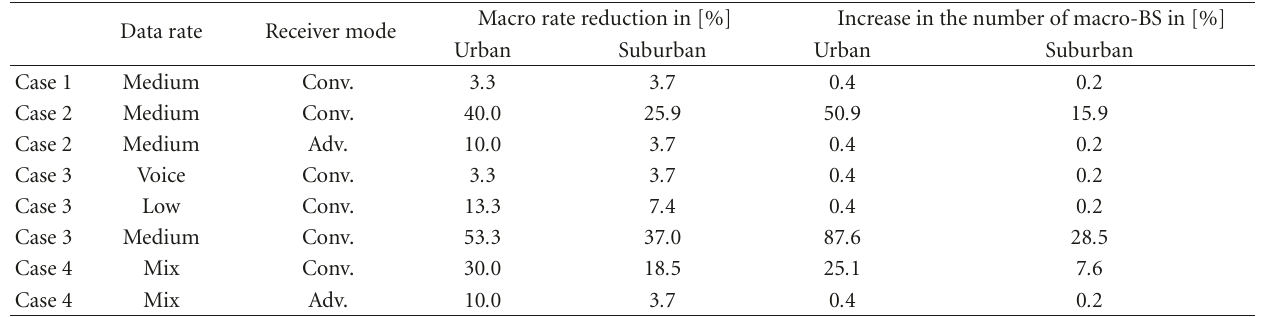
Table 2: Impact on macrocell throughput and range.